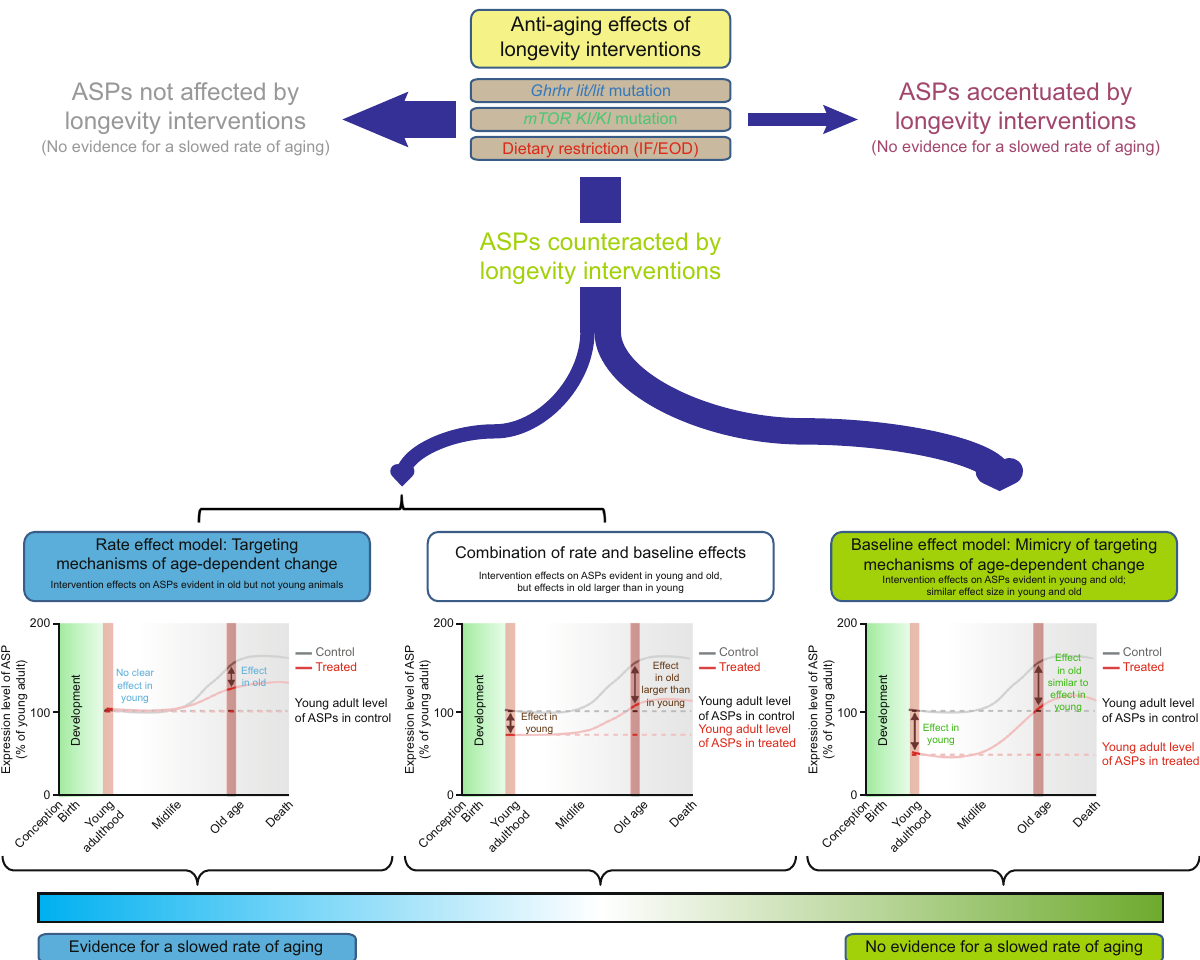
Fig. 9 | ‘ Anti-aging ’ effects were frequently age-independent in nature. The schematic illustrates major scenarios by which PAAIs could in fl uence aging phe- notypes. First, interventions could have no measurable effect on a set of pheno- typesorevenaccentuateage-dependentphenotypicchange.ASPscounteredbyan intervention could be in fl uenced in ways consistent with a targeting of the mechanisms underlying age-dependent phenotypic change: In this case, PAAI effects should become apparent only after the onset of aging-associated pheno- typic change, but not at younger ages (rate effect). PAAI effects at a young age